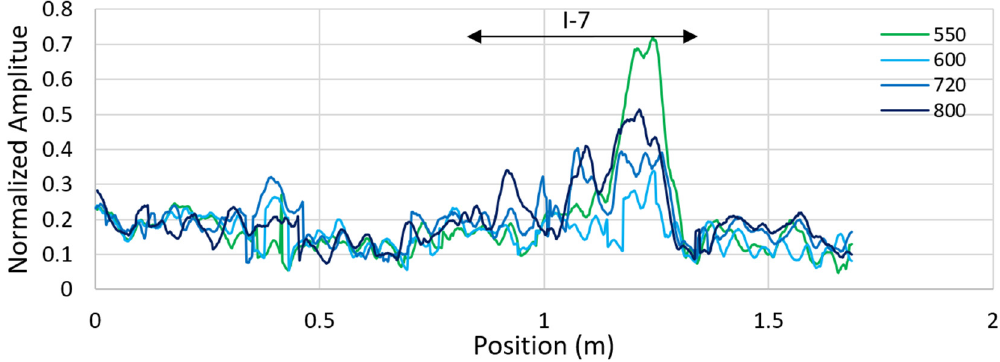
Remote Sens. 2021 , 13 , x FOR PEER REVIEW 22 of 34 Figure 33. 2.6 GHz Normalized RW amplitudes on defect I-7, in the longitudinal direction vs. K loadings.